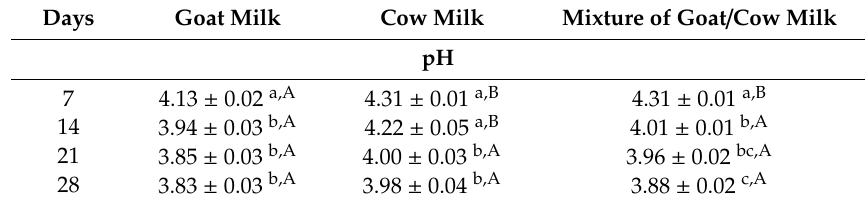
Table 1. E ff ect of storage on pH values of fermented milk produced using goat and cow milk and their